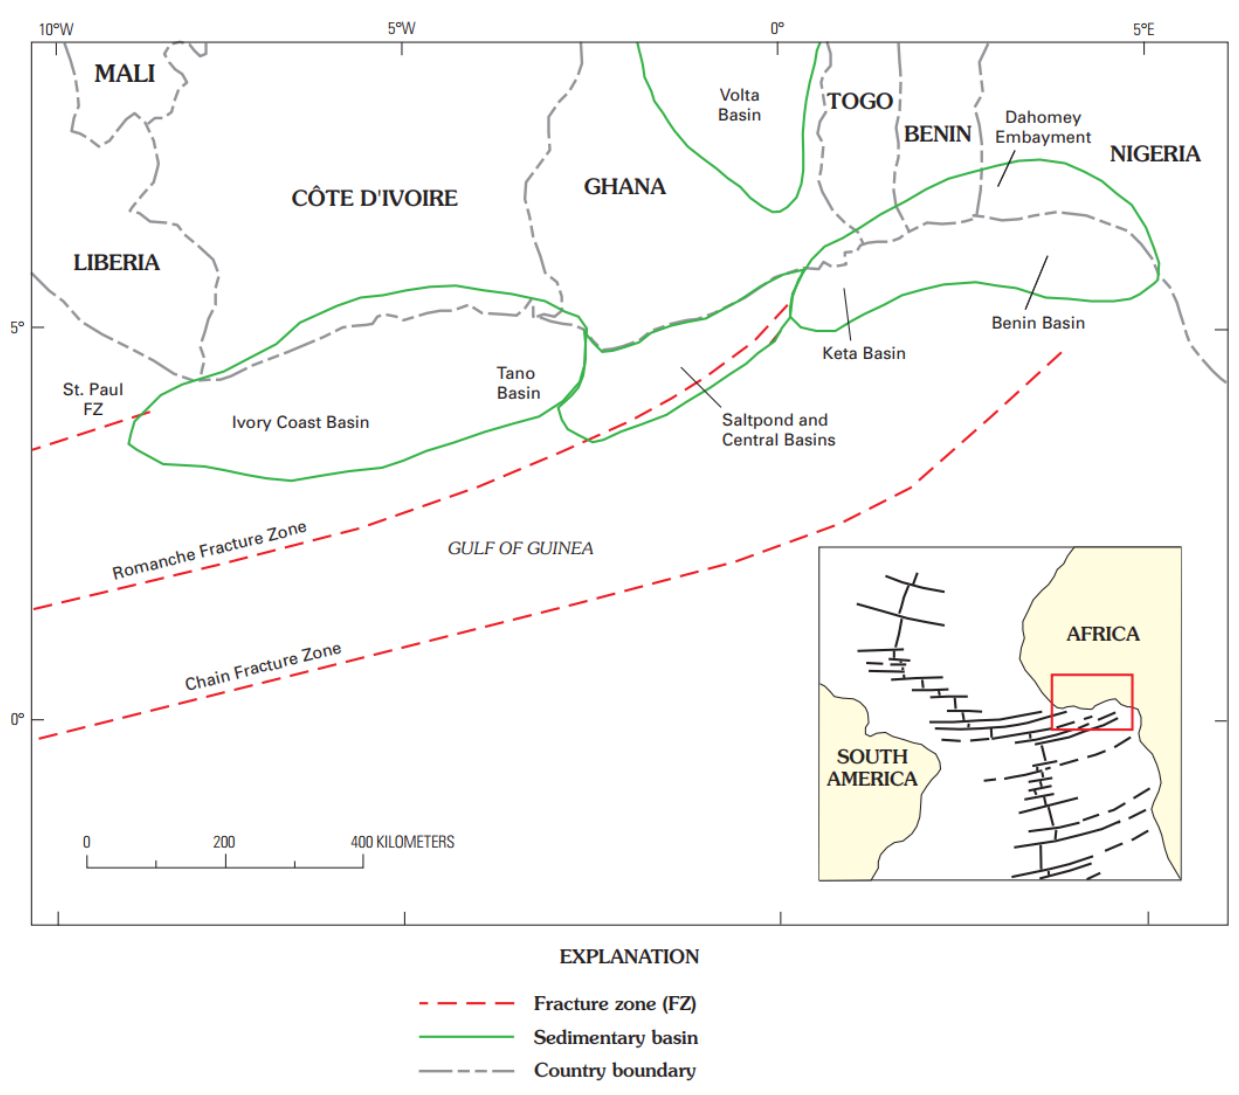
Figure 2. Sedimentary basins in the Gulf of Guinea Province of West Africa from the United States Geological Survey (https://pubs.usgs.gov/bul/2207/C/) (accessed on 2 May 2022) showing major structural features. The Mid-Atlantic Ridge and fractures are shown in the index map.